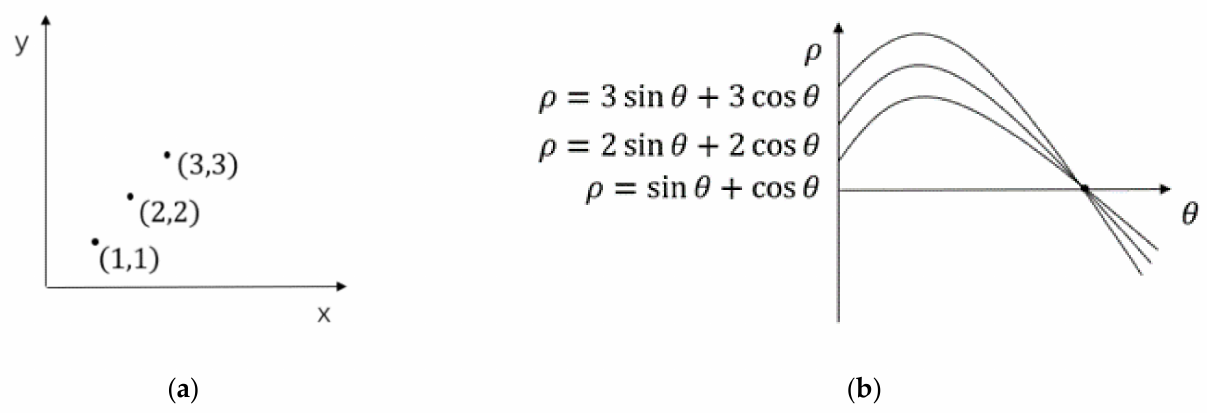
Figure 13. Schematic diagram of a Hough transformation in a polar coordinate system. ( a ) Cartesian coordinate system. ( b ) Hough Cartesian coordinates.